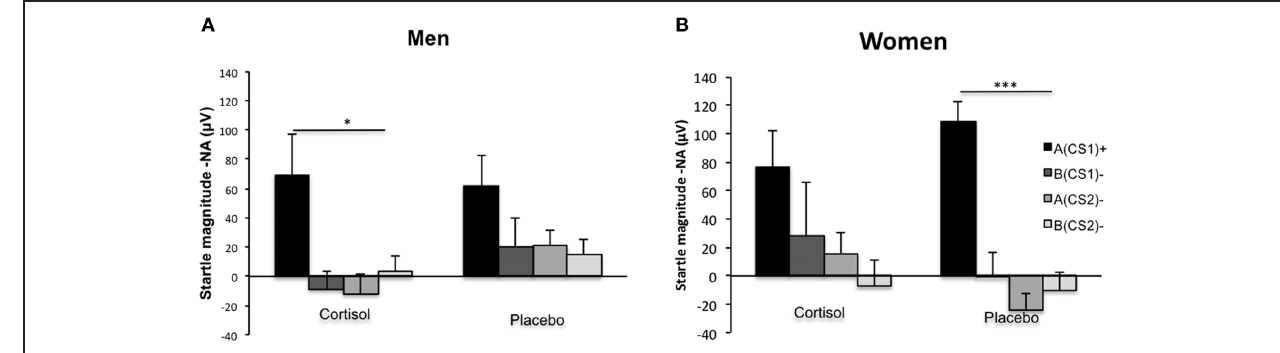
FIGURE 3 | Fear contextualization and fear generalization. Deviations from linearity reflect a significant quadratic component in generalization gradients, and are to be expected in the case of proper fear contextualization. (Panel A ) Shows that men having received the cortisol pill showed proper fear contextualization (significant quadratic component), which was absent after placebo administration, resulting in increased fear generalization (absence of